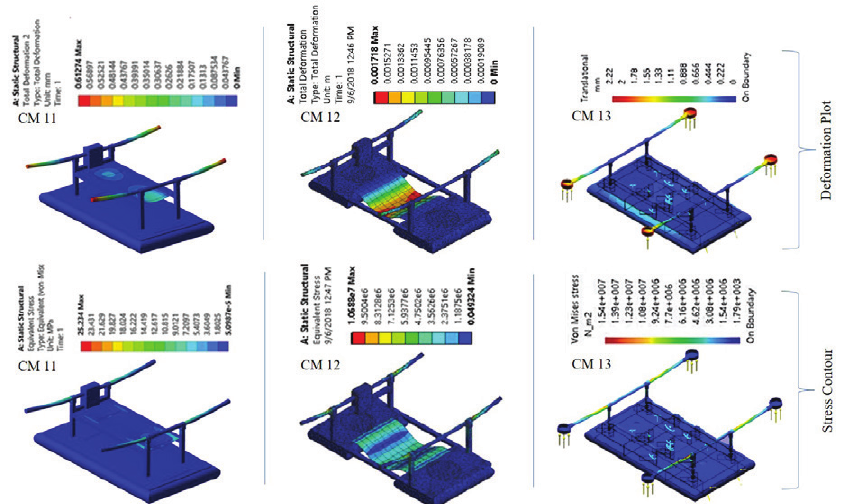
waterFigure 9. Deformation plot and stress contour of amphibious structures – CM 11, CM 12 and CM